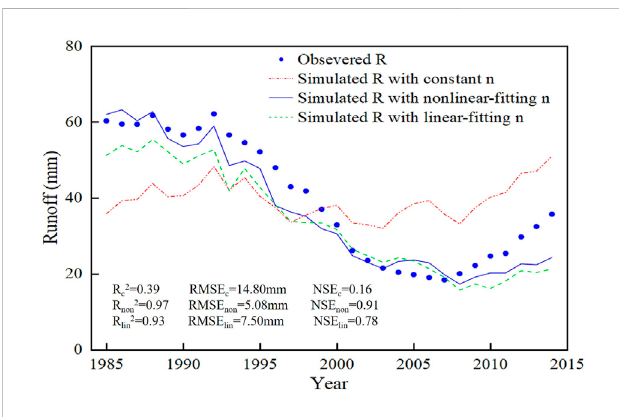
FIGURE 5 Comparison of Simulated runoff by using time-varying underlying surface parameters, linear fi tting underlying surface parameters, and constant underlying surface parameters with observed